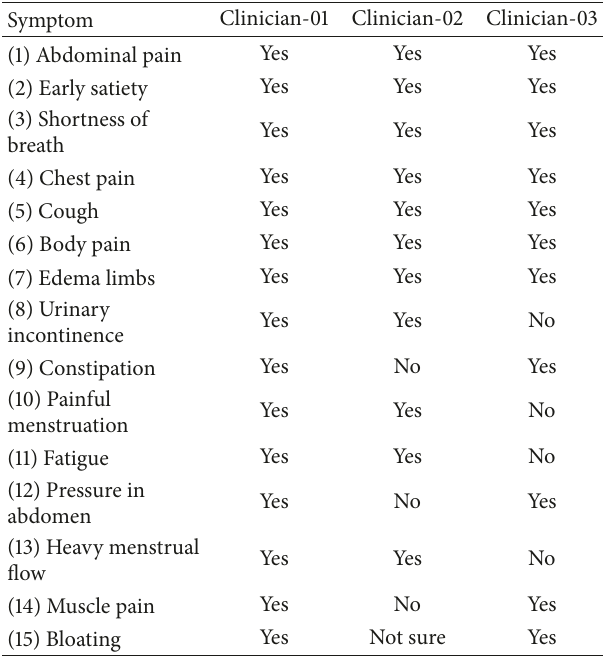
Table 1: Results from clinician